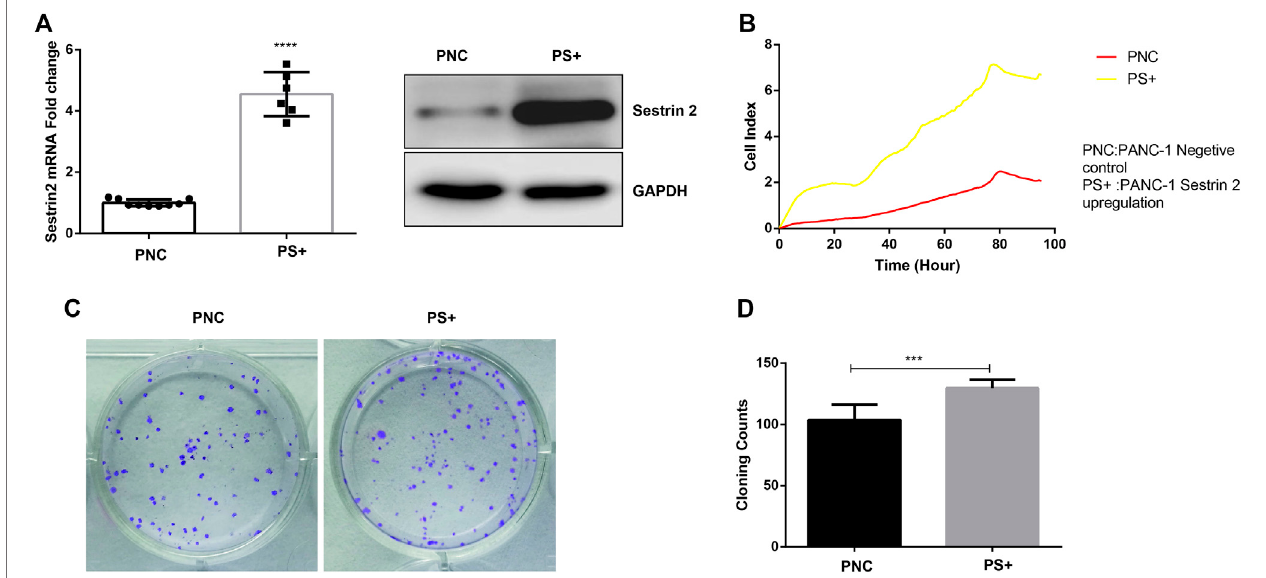
FIGURE 5 | Sestrin2 overexpression promotes the growth and proliferation of PANC-1 cells. (A) qRT-PCR and WB analysis of Sestrin2 in PANC-1 cells after Sestrin2 overexpression. (B) RTCA assay. Sestrin2 overexpression or not of PANC-1 cells were incubated for about 96 h and cell index were automatically recorded every 15 min. (C) Colony formation assay. Sestrin2 overexpression or not of PANC-1 cells were incubated for 14 days. (D) Statistical bar chart of the number of clones. *** p < 0.001.